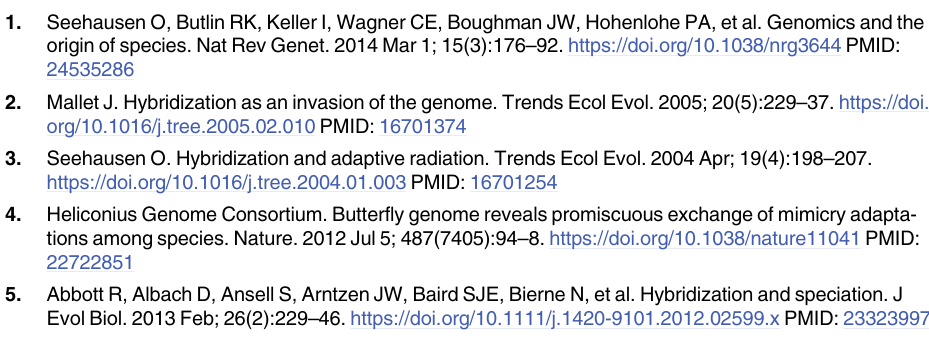
after filtering using the thresholds in A-F for all remaining variants (purple). Vertical dashed lines show the thresholds applied in the study for removing sites. Samples or sites were removed if they exceeded the